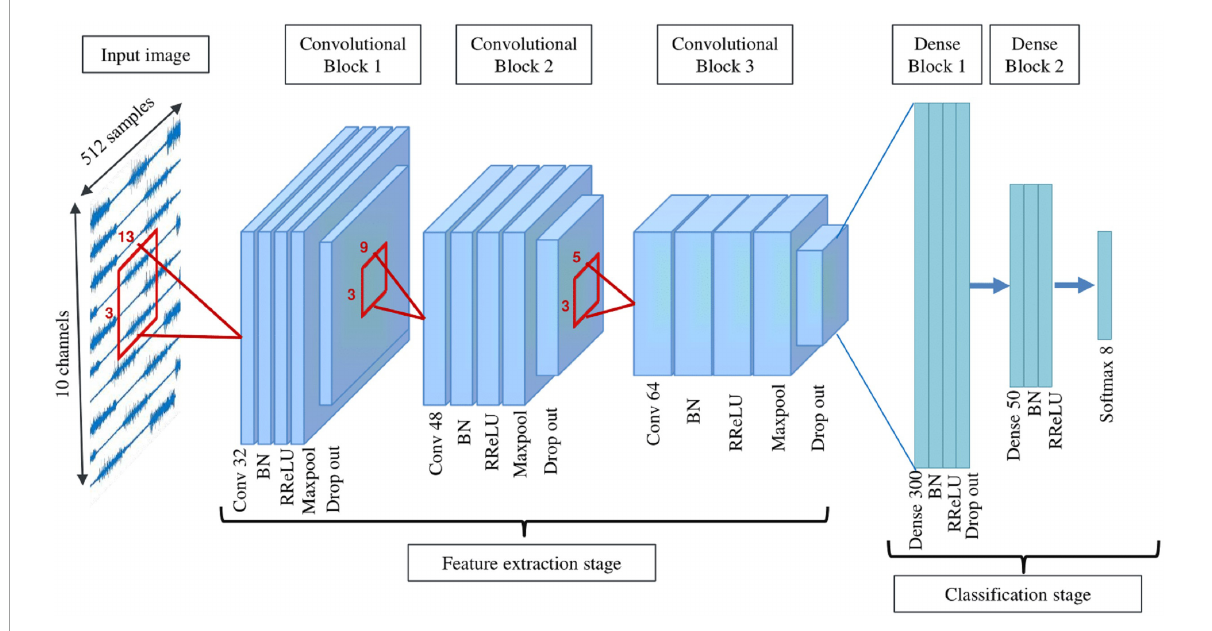
FIGURE3 Schematic of Cnet2D and Cnet1D architecture (filter sizes are one dimensional in the case of Cnet1D).